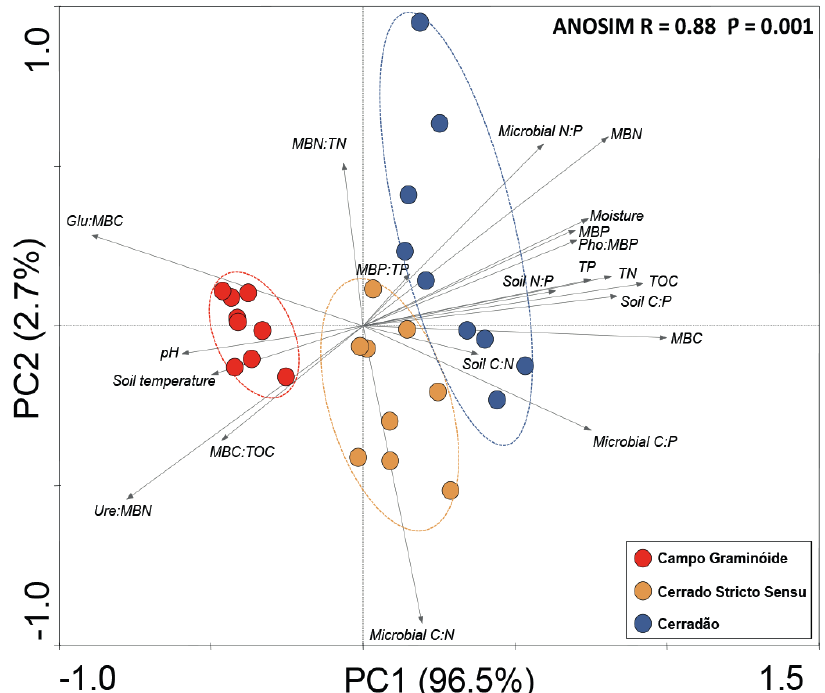
Figure 1 - Principal component analysis (PCA) b ased on the soil and microbial C:N:P across diff erent Cerrado Soil chemical parameters and microbial properties. campo graminóide